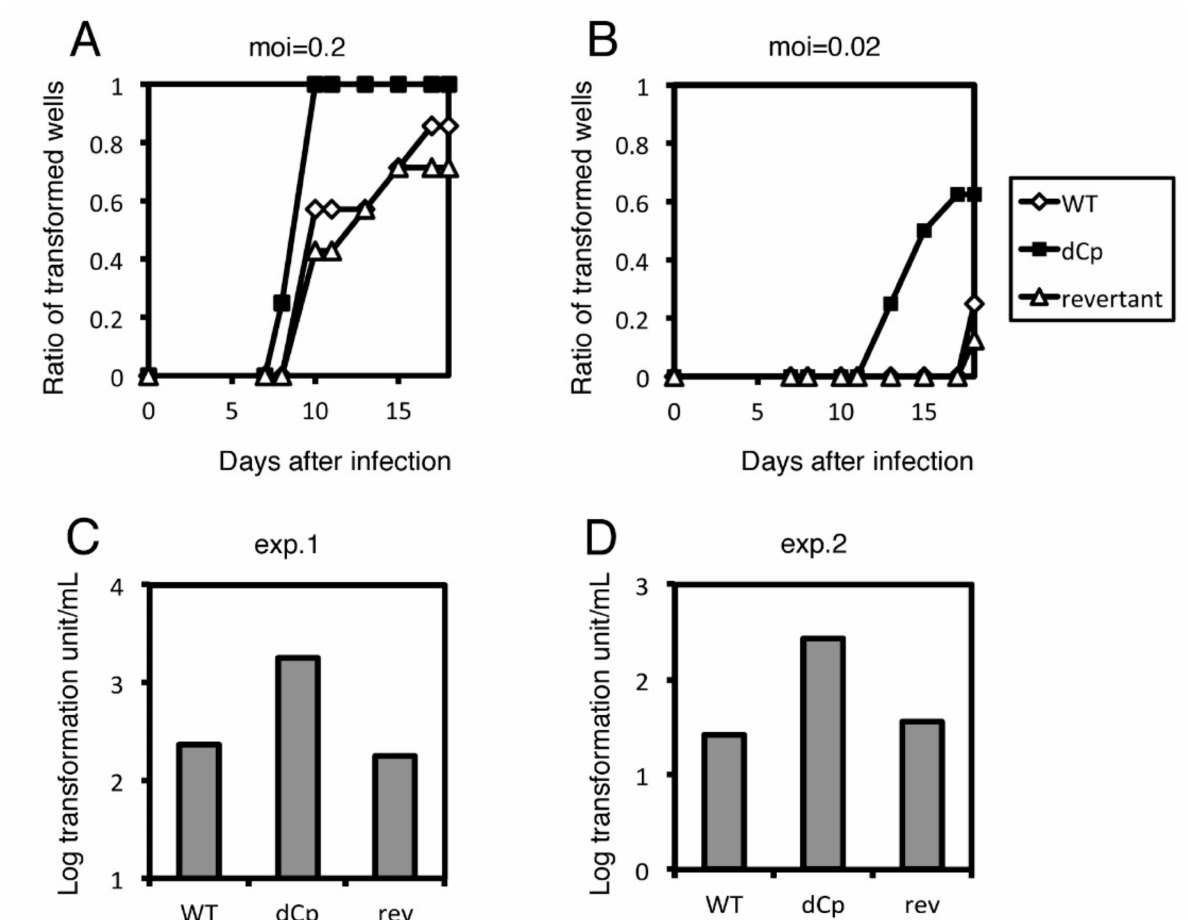
Figure 3. Transformation of WT, dCp and rev viruses. Recombinant viruses (WT, dCp and rev) were produced from HEK293 cells. After titer normalization of the viruses, 10-fold serial dilutions were prepared and used to separately infect peripheral blood mononuclear cells (PBMCs). For each dilution, 8 wells were prepared. ( A , B ) Ratio of transformed wells with a multiplicity of infection (MOI) of 0.2 ( A ) and 0.02 ( B ) over time. ( C , D ) Transformation efficiency at 3 weeks post-infection. Two independent experiments were carried out using PBMCs from two healthy donors (exp. 1 and exp.